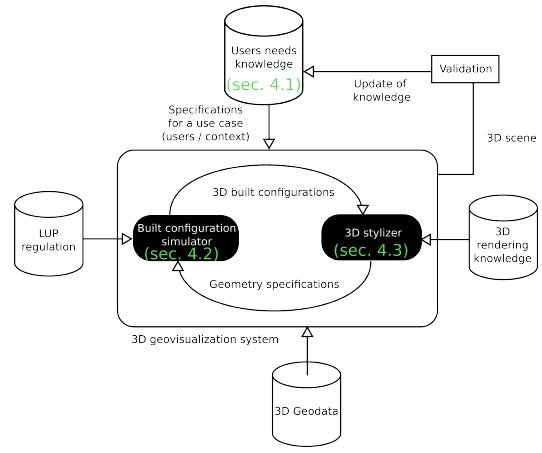
Figure 2. Pipeline of the global